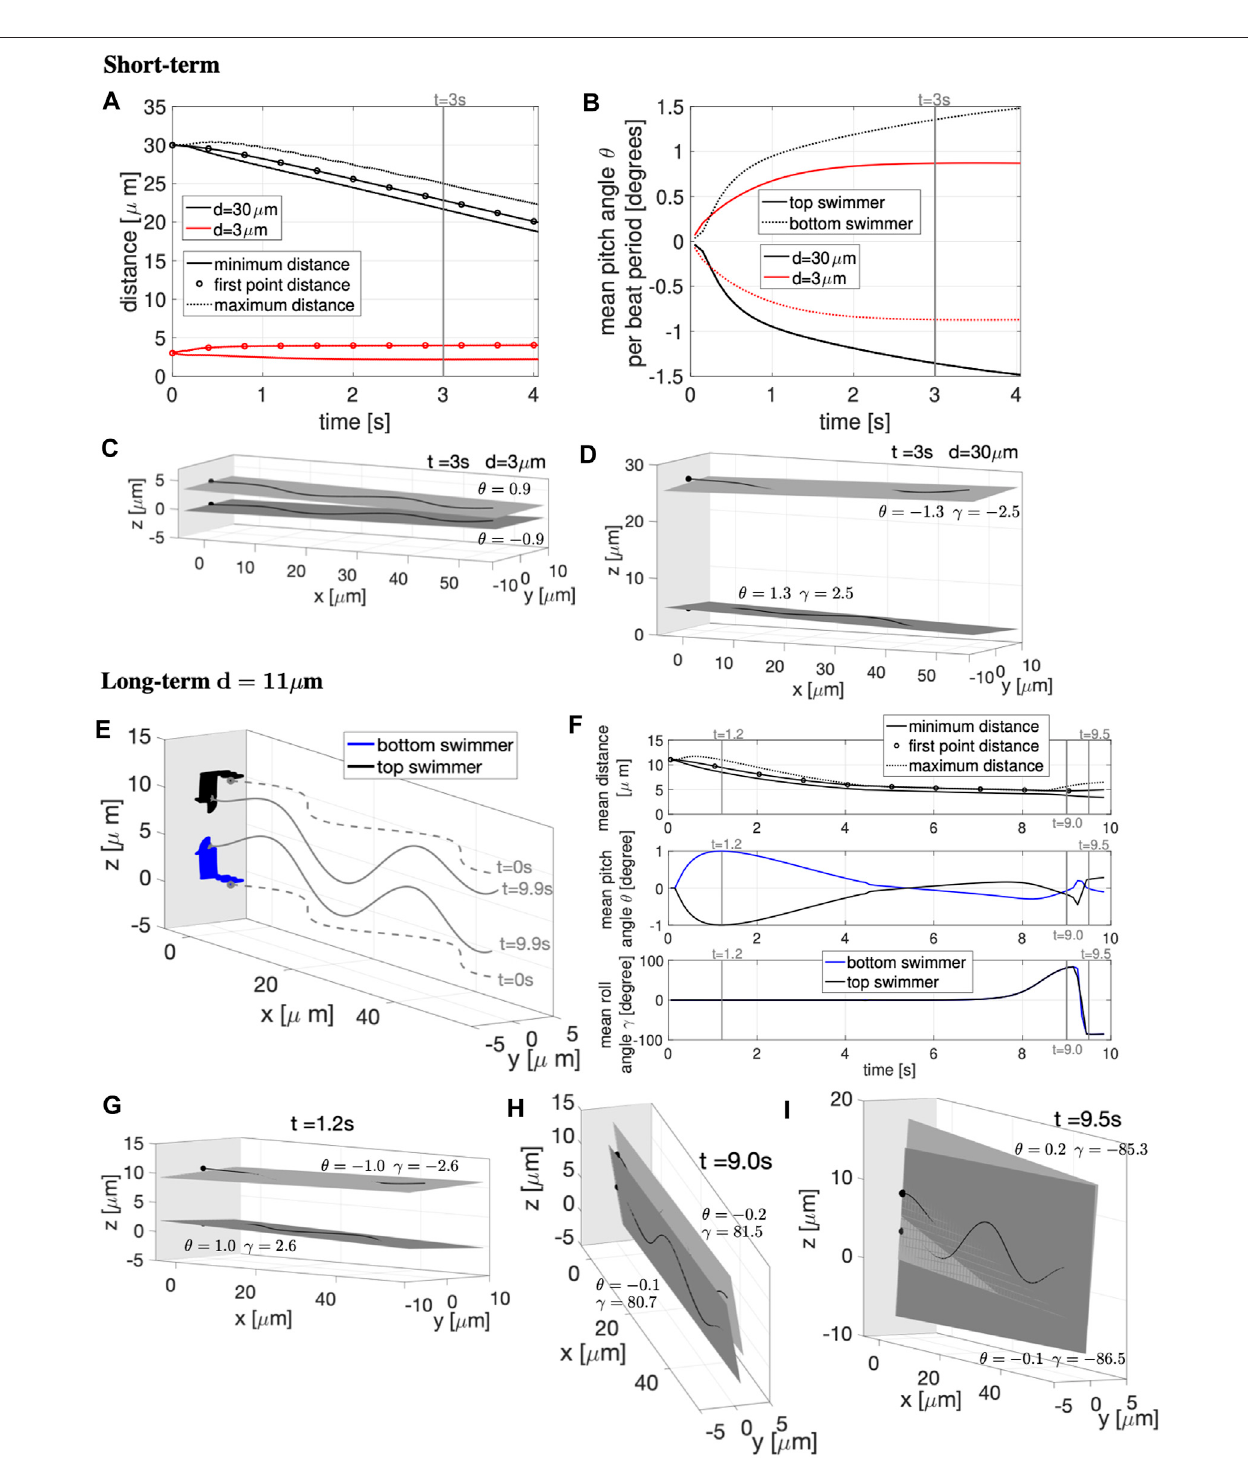
FIGURE 7 | Parallel Sperm Near a Wall. Sperm with planar beat forms initialized in parallel planes ( z (cid:1) 0 and z (cid:1) d ) near a wall at x (cid:1) − 5 μ m. (A – D) : Short-term behavior for initial distances d (cid:1) 3, 30 μ m. (A) Minimum (solid lines) and maximum (dotted lines) distance between the two swimmers and distance between the fi rst points ofthetwoswimmers (circles). (B) Pitching angle θ ofthe topand bottom swimmers intime.The topand bottom swimmersbeatingplanesfor d (cid:1) 3 μ misin (C) and d (cid:1) 30 μ misin (D) ,bothattime t (cid:1) 3 s. (E – I) :Long-termbehaviorfor d (cid:1) 11 μ m. (E) Swimmercon fi gurationsat t (cid:1) 0 s(graydashedlines)andtracesofthe fi rst point in time (colored solid lines). Corresponding beating planes of the swimmers for three snapshotsare in (G – I) . The timeschosen for the snapshots are identi fi ed with vertical gray lines in (F) , which has distance between the swimmers in the top panel, pitching angle θ in the middle panel, and rolling angle c in the bottom panel. In (C – E , G – I) , a fi lledinsphereisused to denote theswimmer fi rst point in thedirectionofmotion. Thelightgray planein (C – E , G – I) represents thewall (and thedarkergray planes are the beating planes).